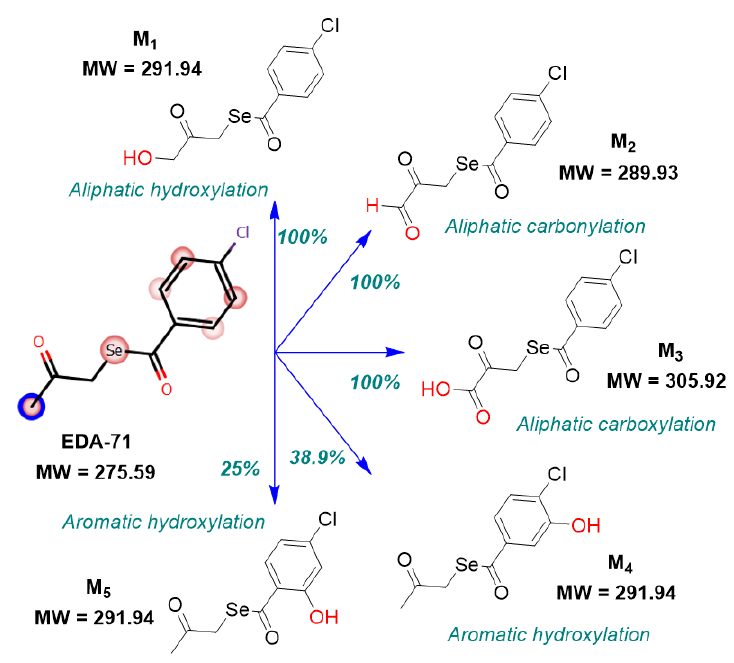
Figure 3. In silico metabolic stability of EDA-71 selenoester estimated with MetaSite. In this figure, the dark red color of atoms marked with circles indicates a higher probability to be involved in metabolic pathways. The blue circle marks the site of EDA-71 , which was found to be involved in metabolism with the highest probability (100% score). According to in silico data, the highest probability of metabolism is at the terminal position of selenoester moiety